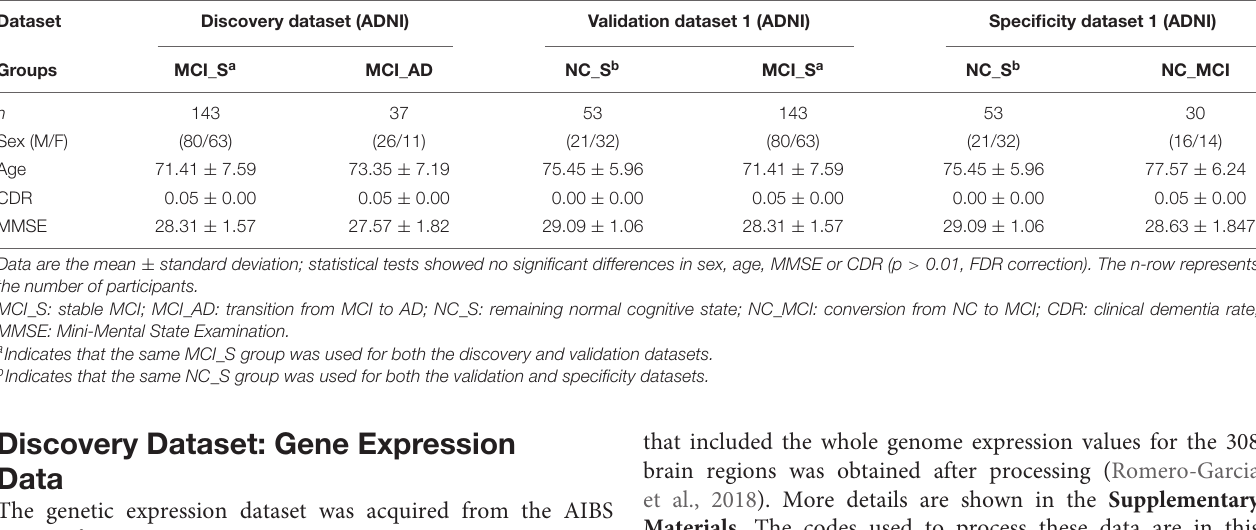
FIGURE 1 | Flowchart of this study. (A) Cortical thickness difference ( (cid:49) CT) of 308 brain regions between the MCI_S and MCI_AD groups. (B) Regional expression of 20,647 genes in 308 brain regions from the AIBS. (C) Partial least squares regression (PLSR) analysis using gene expression as a predictor variable and (cid:49) CT as a response variable. (D) PLSR weights of all genes in line with its contribution to the overall model in each component (FDR correction, z-score > 1.96). (E) Upregulated genes are tested for enrichment analysis and spatial expression of von Economo classes. (F) Validation of robustness and specificity of our results. (G) Validation of robustness and specificity. TABLE 1 | Demographic information in discovery dataset, validation dataset 1 and specificity dataset